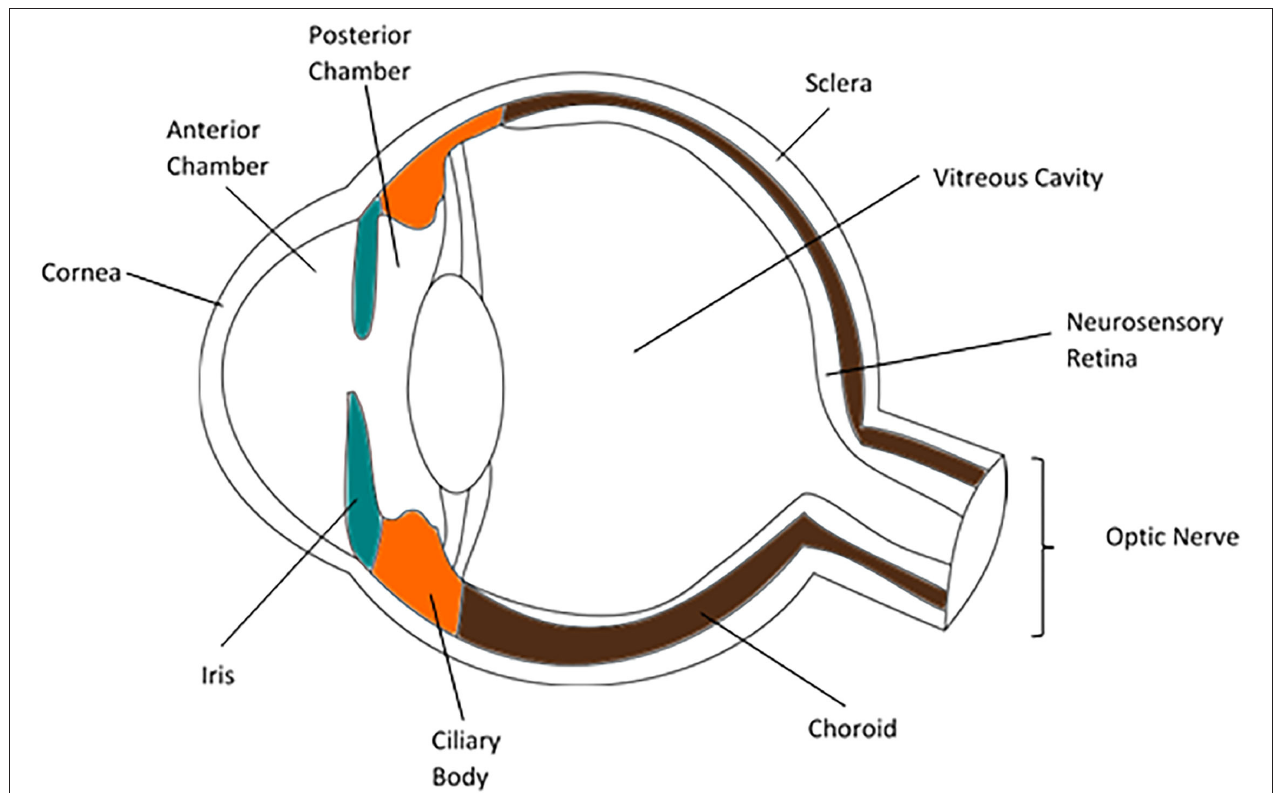
FIGURE 1 | Diagram of a cross section of an eye, highlighting the iris (blue), ciliary body (orange) and choroid (brown).